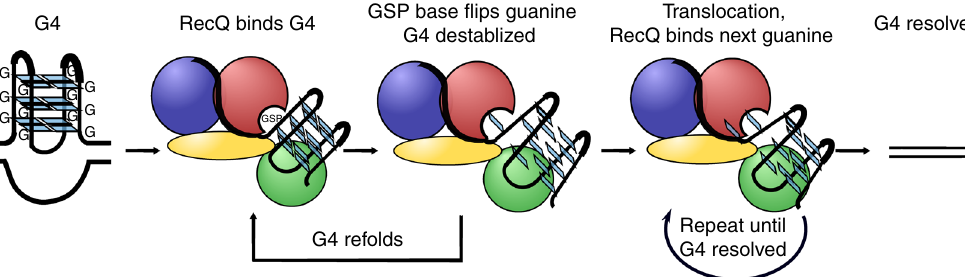
Fig. 3 Model of RecQ-mediated G4 unwinding. RecQ (domains colored as in Fig. 1) binds the folded quadruplex, trapping it between the helicase and winged-helix domains. This positions the GSP near the G4, allowing for a guanine (indicated by blue squares) to be fl ipped out of the G-quartet and sequestered in the GSP. The guanine can either release back into the G-quartet, allowing the G4 to refold and leading to the observed repetitive FRET cycling, or RecQ can translocate to the